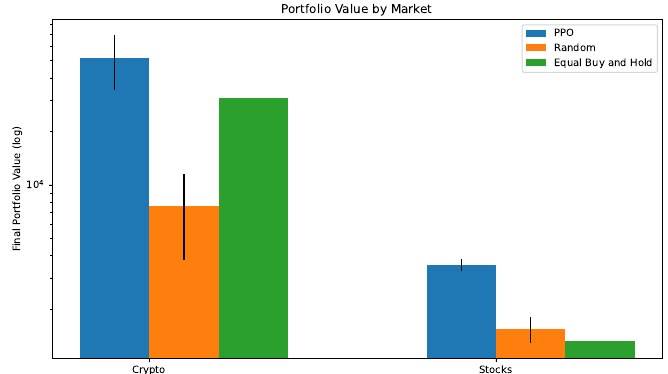
Figure 6. Portfolio value by